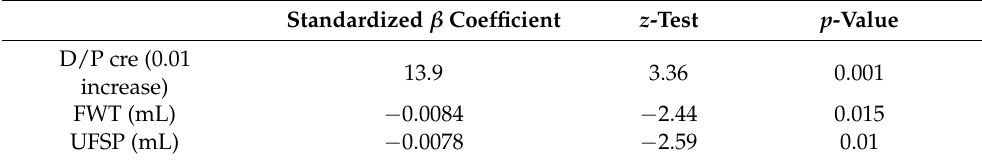
Table 4. Multivariate analysis of UF over repeated uni-PET tests (Random effects logistic regression).